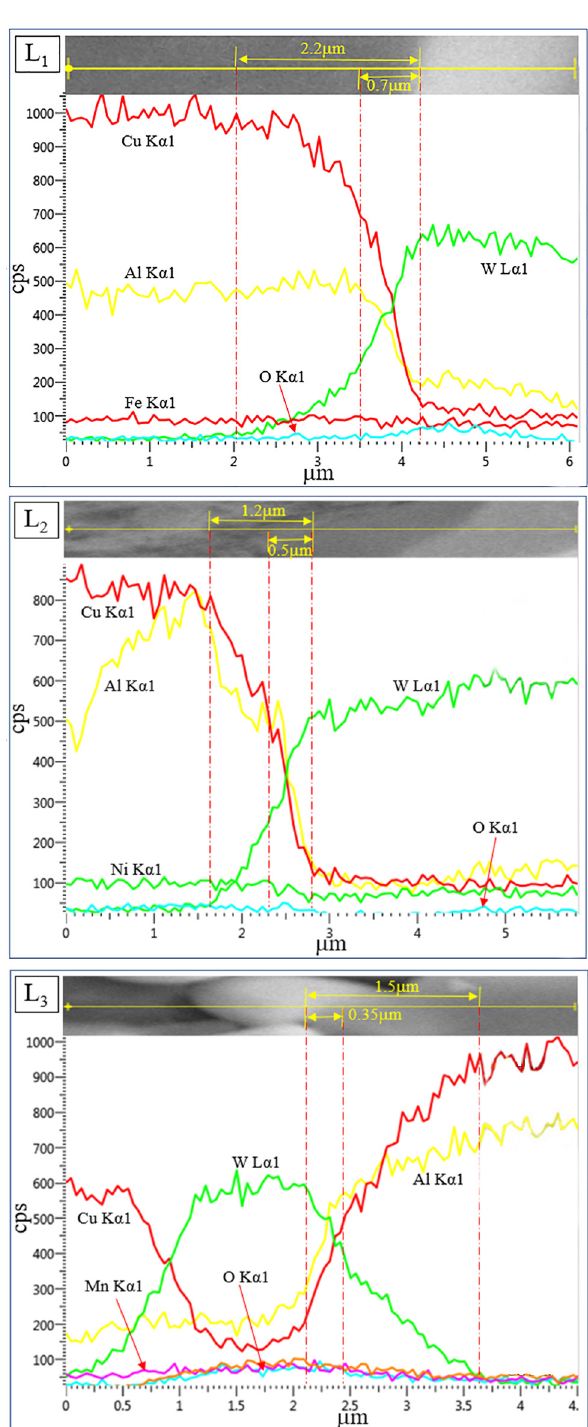
Figure 7: Line scan analysis of typical W/Cu interfaces in Figure 6 ( L 1 : Fe, L 2 : Ni, and L 3 : Mn